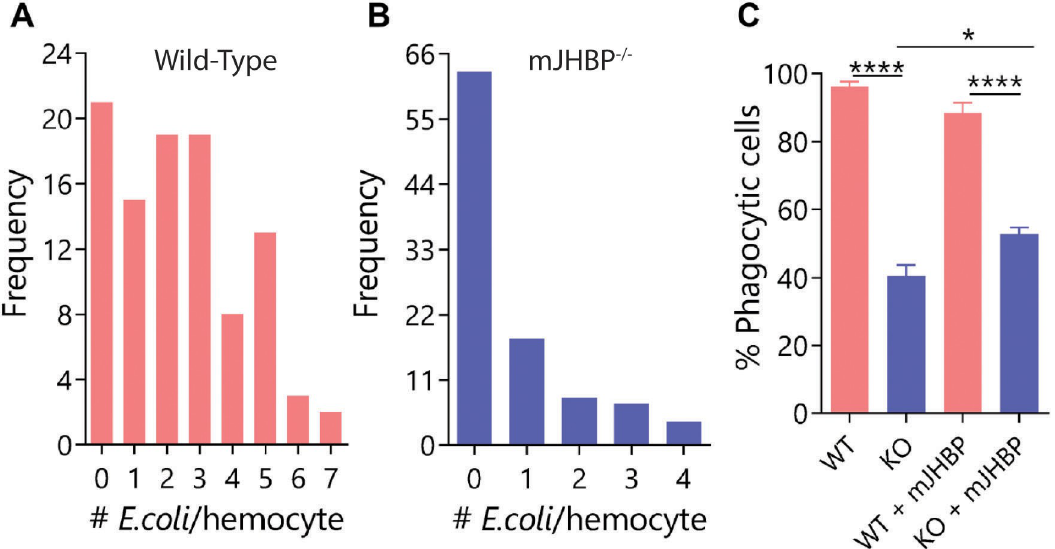
Fig 8. Phagocytic capabilities of hemocytes perfused from newly emerged WT and KO females. Phagocytic capacity of hemocyte from WT ( A ) and KO ( B ) lines. Data shown represents the frequency distributions of fluorescent pHrodo E . coli bioparticles per individual granulocyte (phagocyte). Two biological replicates were performed in which 10 granulocytes per mosquito from at least three fields were counted. In each replicate 5 mosquitoes were analyzed. C . Effect of biologically active and mutant mJHBP protein injection on the phagocytic activity (mean % ± SEM) of granulocytes in WT and KO lines. Two biological replicates were performed in which granulocytes were counted as in panels A and B. In each replicate, granulocytes from 7–12 mosquitoes were evaluated. Significance levels (Mann-Whitney U test) are indicated with asterisks ( ���� p � 0.0001, � � 0.05).